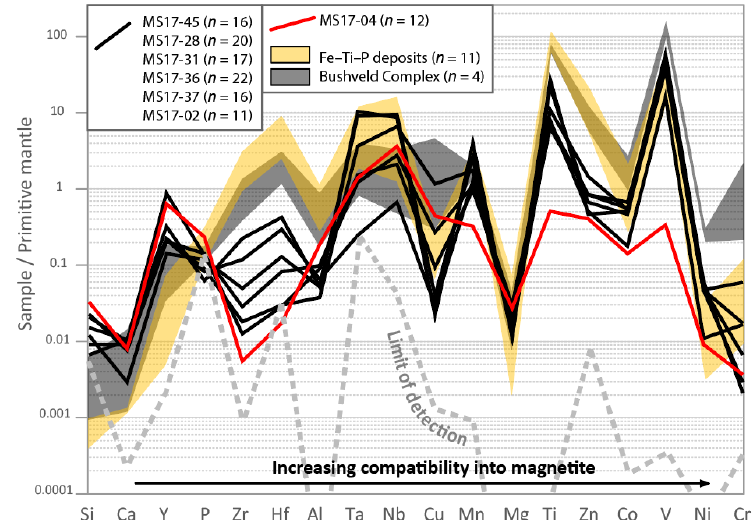
Figure 12. Trace element profiles (median values for n samples) of magnetites analyzed by LA-ICP-MS and normalized to the primitive mantle [43]. The elements are ordered by increasing compatibility in magnetite [44]. The LDC magnetites are compared to magnetites reported by Dare and collaborators [44] and collected from: ( 1 ) Fe–Ti–P deposits from several intrusions; and ( 2 ) a massive magnetite unit in the Bushveld Complex.